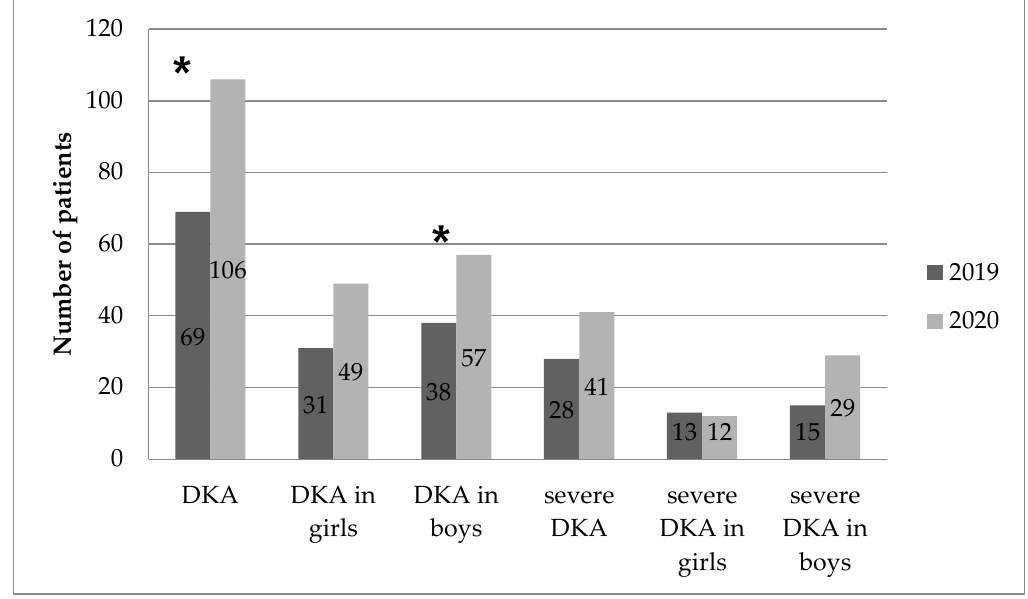
Figure 1. Number of DKA and severe DKA in children in 2019 and 2020. * — p < 0.05.